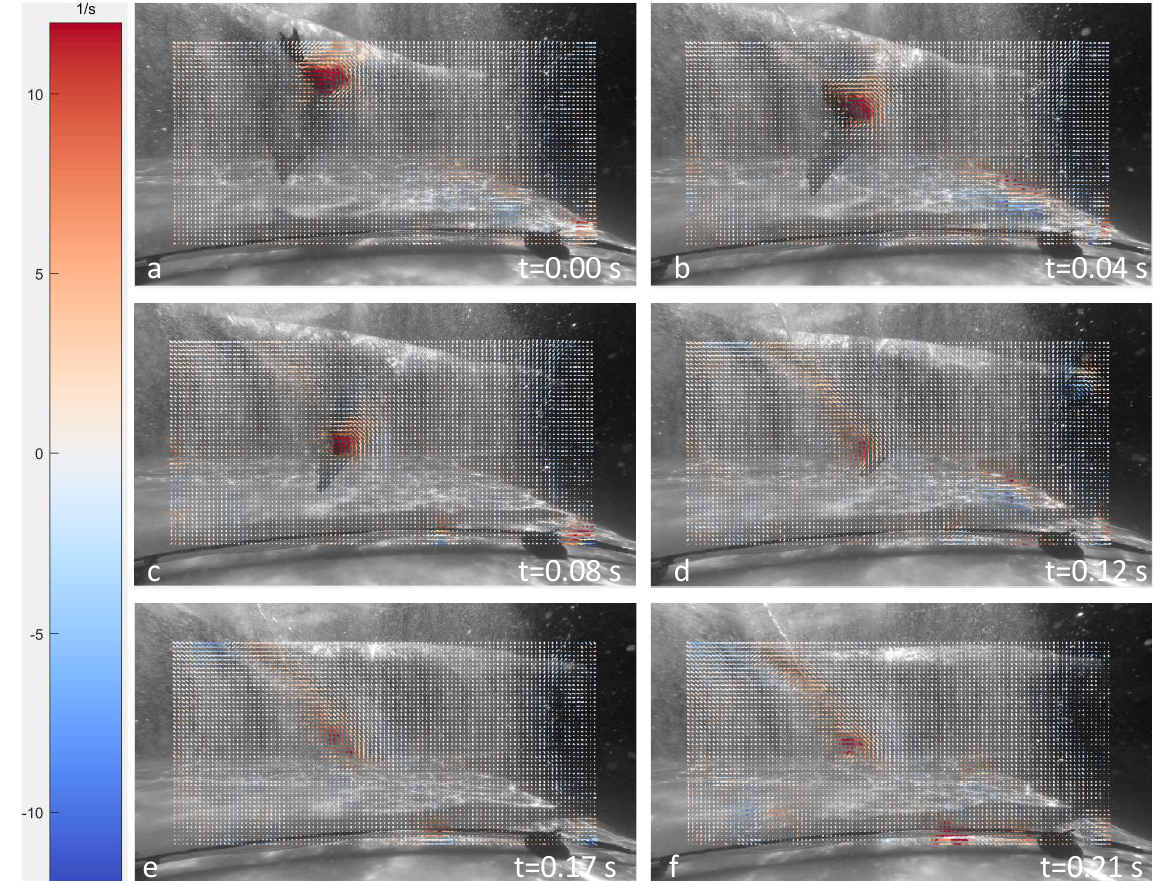
Figure 7. The vorticity fields calculated from the bubble PIV (shown in Figure 5) of a swimming sea lion were plotted at 6 instances as the sea lion completed a propulsive stroke in the plane of the bubble sheet: ( a ) as the animal enters the sheet, ( b – d ) while the propulsive stroke is actively being completed, and ( e,f ) while the sea lion glides through the measurement plane. Images show raw data (underlay) with vorticity magnitude (colormap) and velocity vectors.